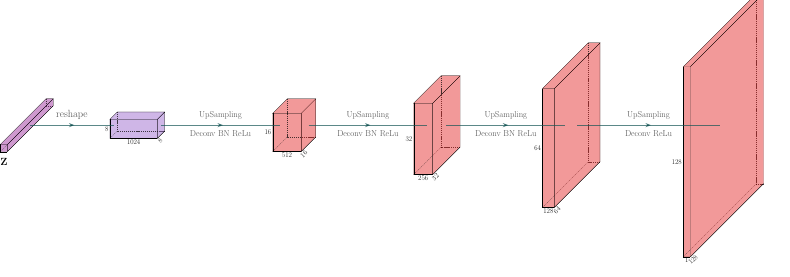
Figure 12. The network structure of generator in DCGAN. Deconv is the abbreviation of deconvolu- tions. BN is the abbreviation of batch normalization. Relu is activation